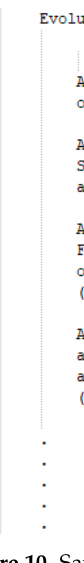
Figure 10. Sample of the agent’s evolution rules in MCMAS